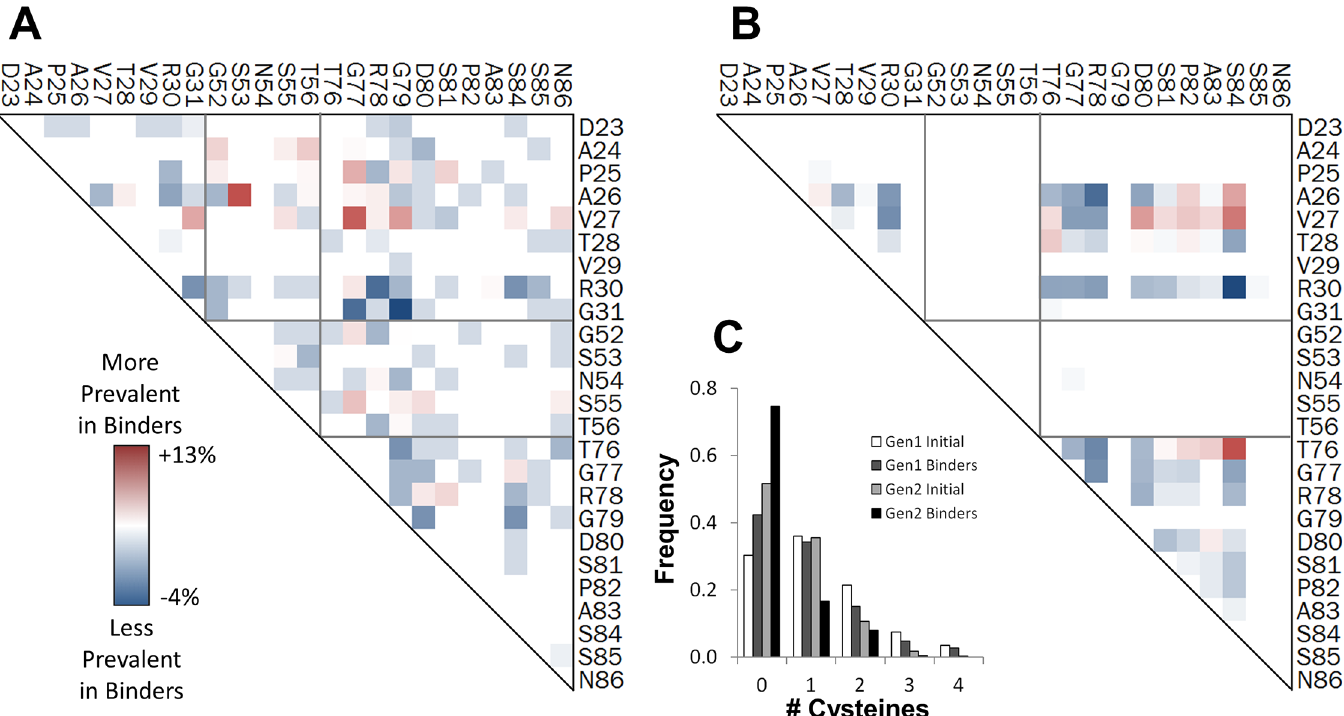
Fig 6. Cysteine frequency analysis. (A, B) Change in pairwise frequency of clones containing exactly two cysteines (high-affinity populations minus na ï ve library) for the first generation (A) and second generation (B) libraries. (C) Frequencies of clones containing the indicated number of cysteines in initial libraries and binder